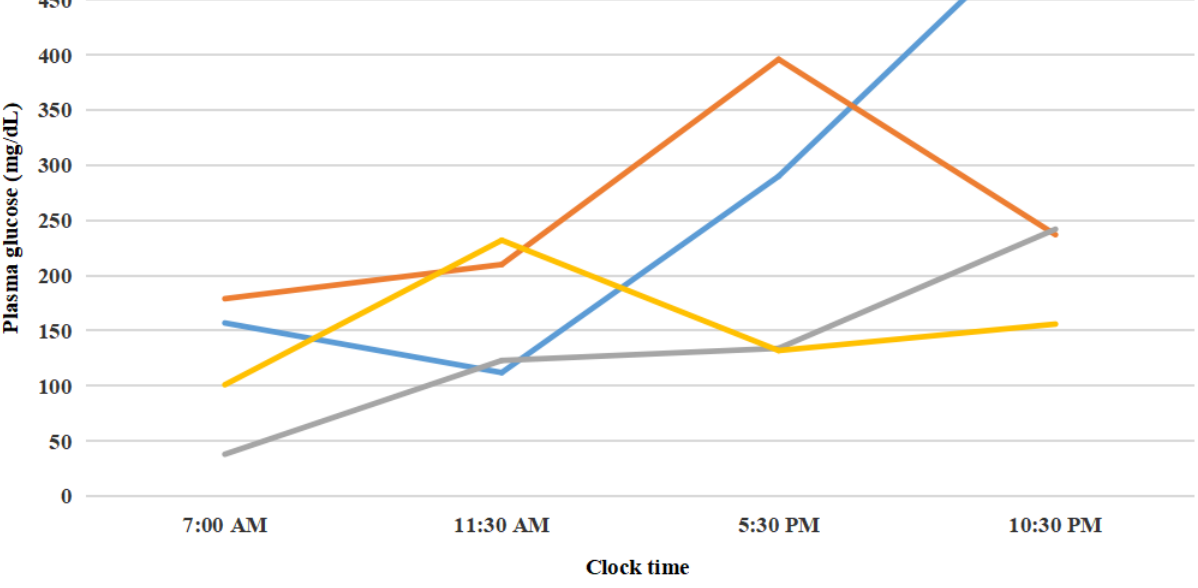
With appropriate insulin therapy, glycemic stabilization was achieved which allowed full recovery of general and neurological conditions at